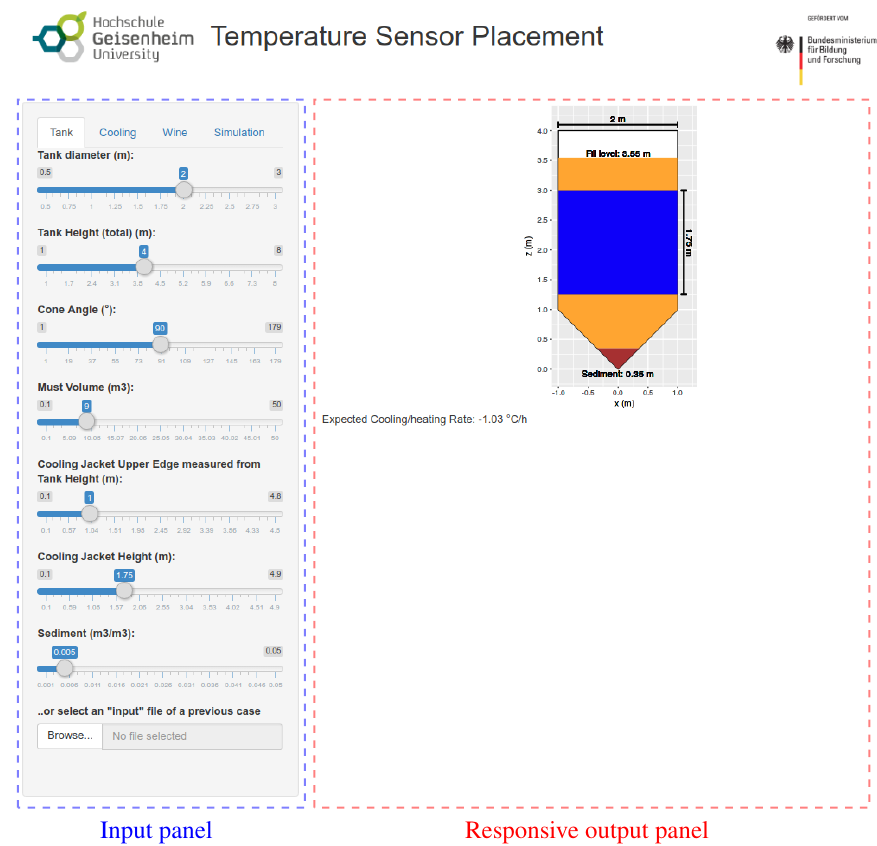
Figure 1. Screenshot of the graphical user interface. Dashed boxes indicate the input ( left ) and the responsive information panel ( right